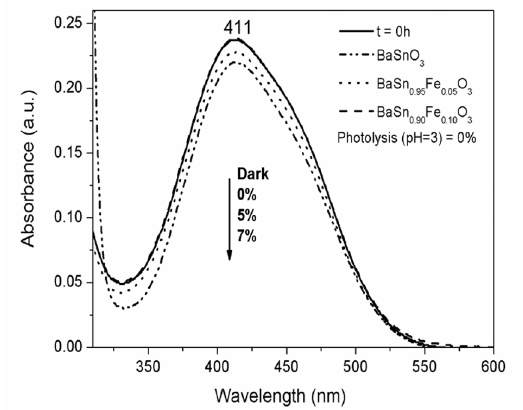
Figure 7. Evaluation of RNL adsorption at pH = 3 after 4 h for the samples BaSn Fe O (x = 0, 0.05 and 0.1 in 1-x x 3